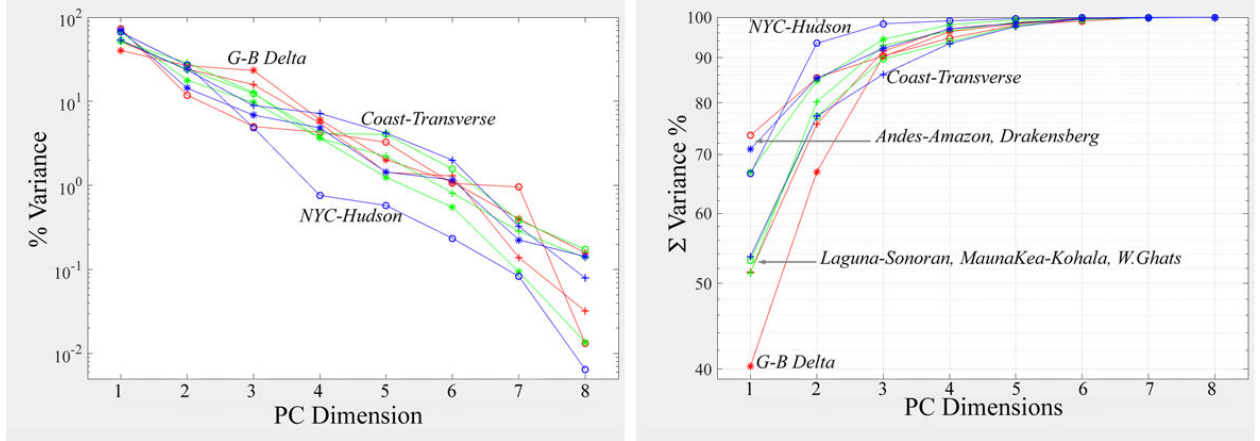
Figure 4. Variance partition of Dynamic World class probability feature spaces for 9 spectral diversity hotspots. Note logarithmic scaling on % variance plot. All but NYC-Hudson are effectively 5D, requiring 5 dimensions to represent >95% of the total feature space